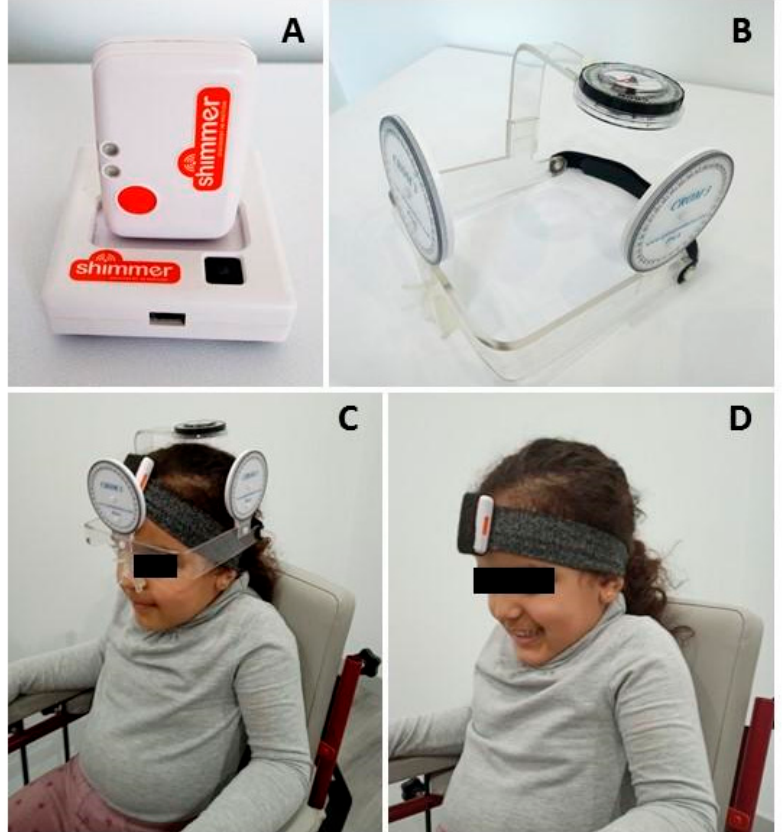
Figure 1. Devices and procedure of assessment. ( A ) Inertial Measurement Unit (IMU) Shimmer3 ® (Dublin, Ireland); ( B ) Cervical Range of Motion (CROM) 3 ® device (Lindstrom, MN, USA); ( C ) positioning of IMU and CROM to assess craniocervical range of motion (first assessment on the first day); ( D ) positioning of IMU to assess craniocervical range of motion (second assessment on the first day, and assessment on the second day).